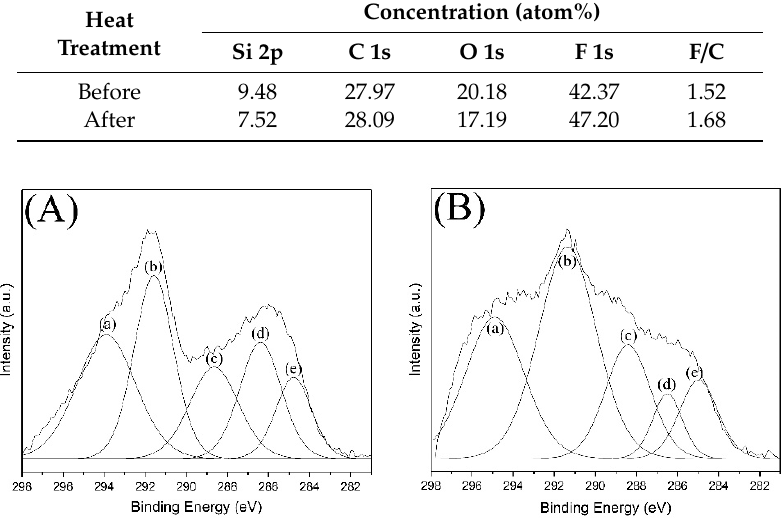
Figure 10. XPS C1s patterns of the spray-coated 12 nm-SiO 2 (46)@PFMA surface ( A ) before heat treatment and ( B ) after heat treatment at 150 °C.